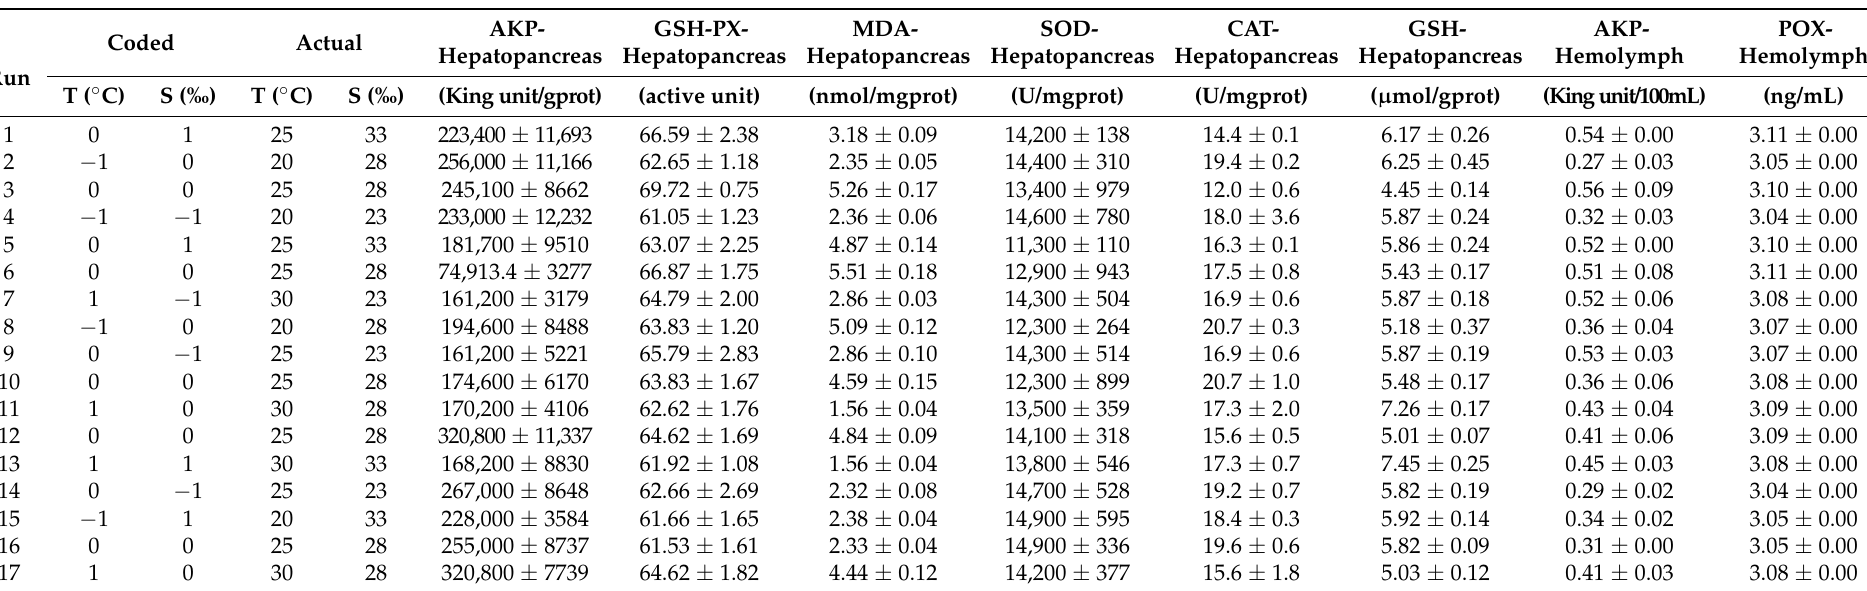
Table 2. Experimental design and results of biochemical indicators related to immunity and antioxidation response